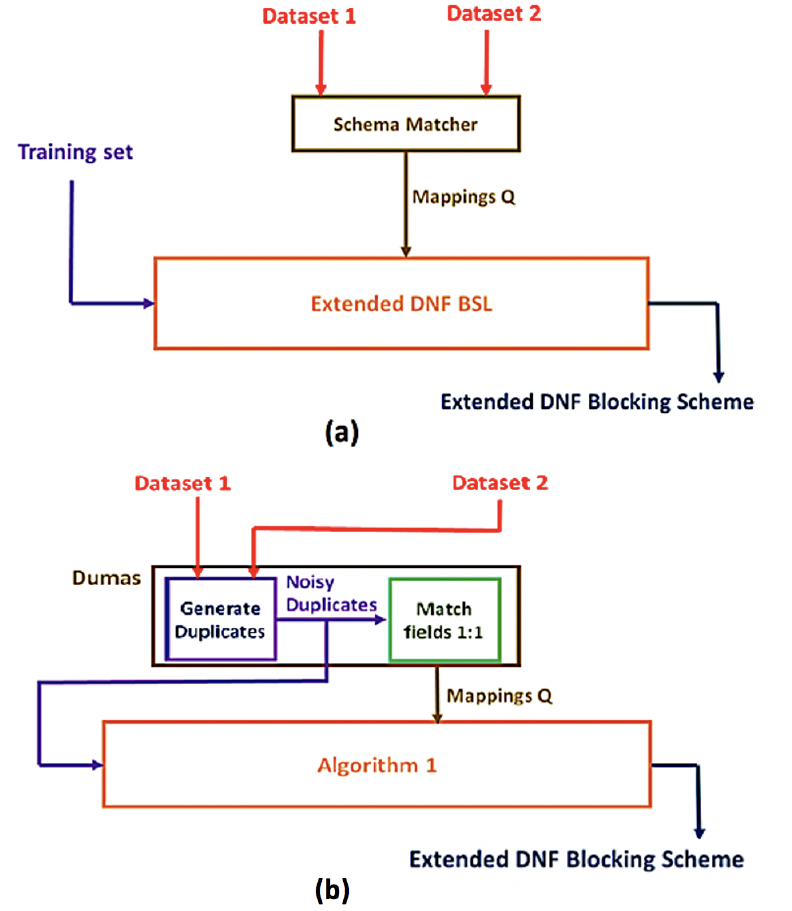
Figure 4. ( a ) shows a generic pipeline for learning a DNF blocking scheme on heterogeneous datasets, with ( b ) showing an unsupervised